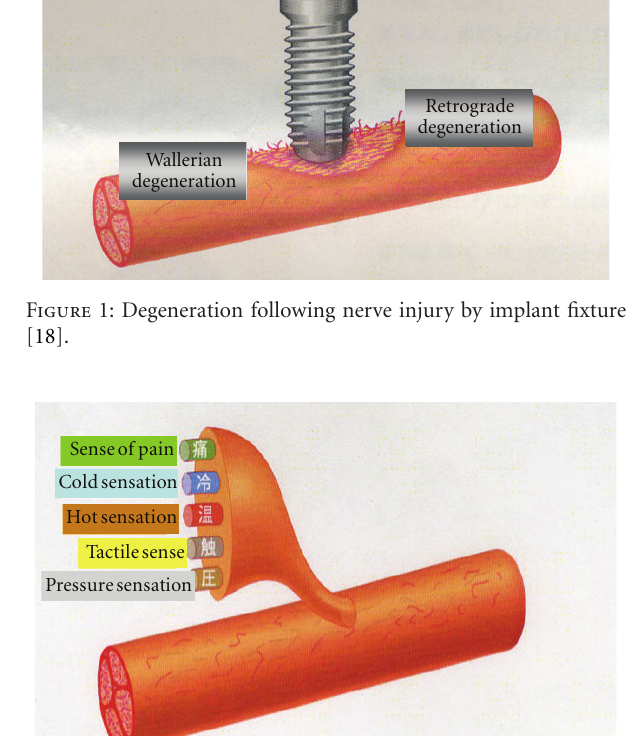
regeneration is activated. These defense mechanisms and repair reactions can be completed within 2 to 3 weeks. That is to say, the nerves are reconnected quite quickly unless neuropathy is severe or severance has occurred. Although connections may recover histologically, however, function does